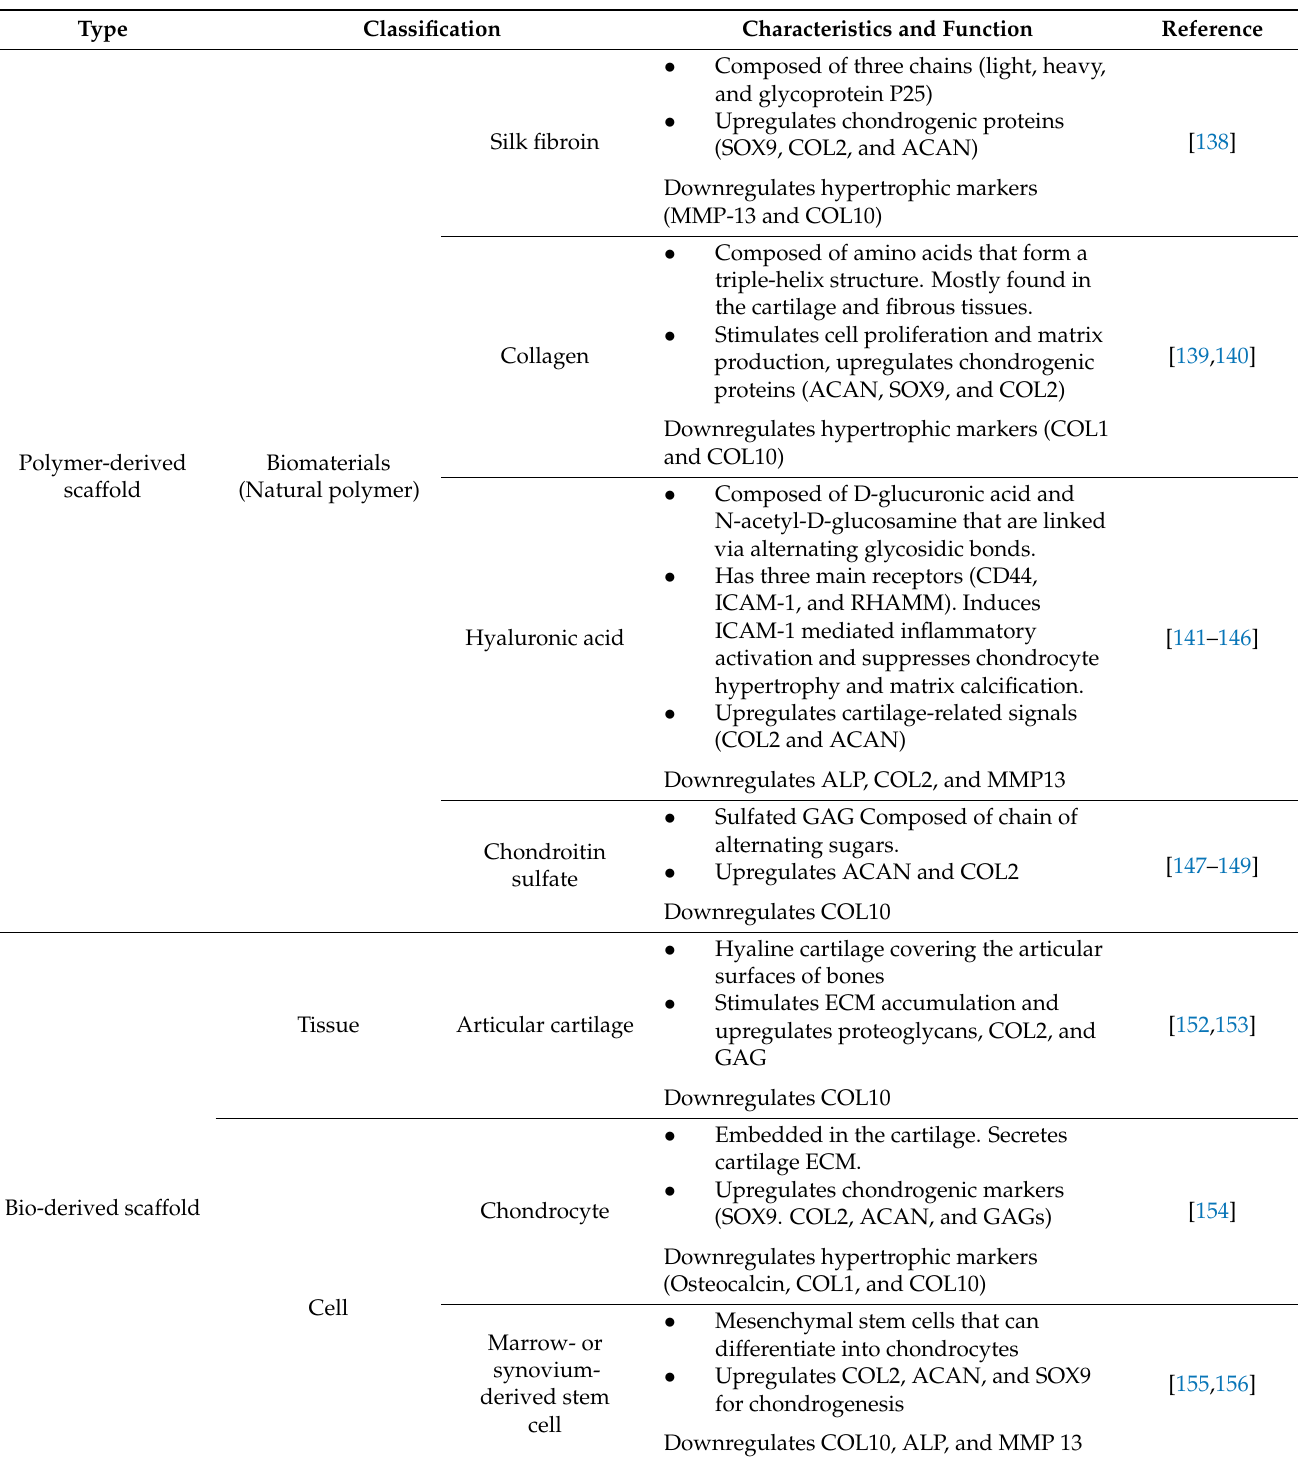
Table 2. Various polymer- or bio-derived scaffolds propose for use in the treatment of